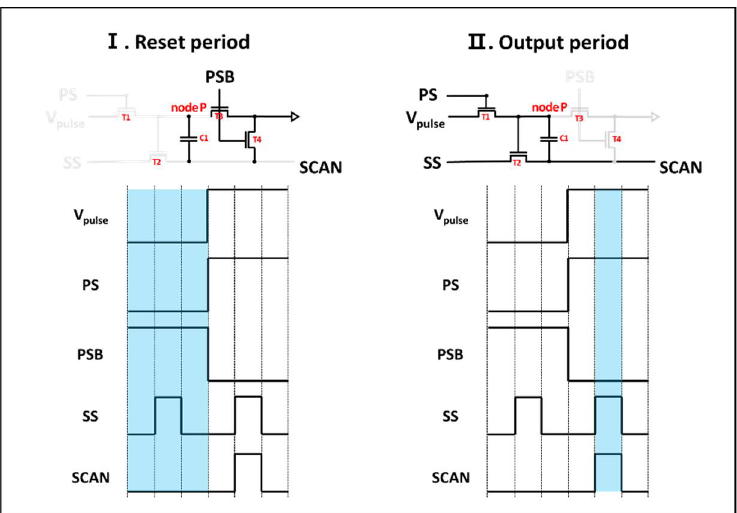
Figure 6. Operation of the modified bootstrap scan driver.